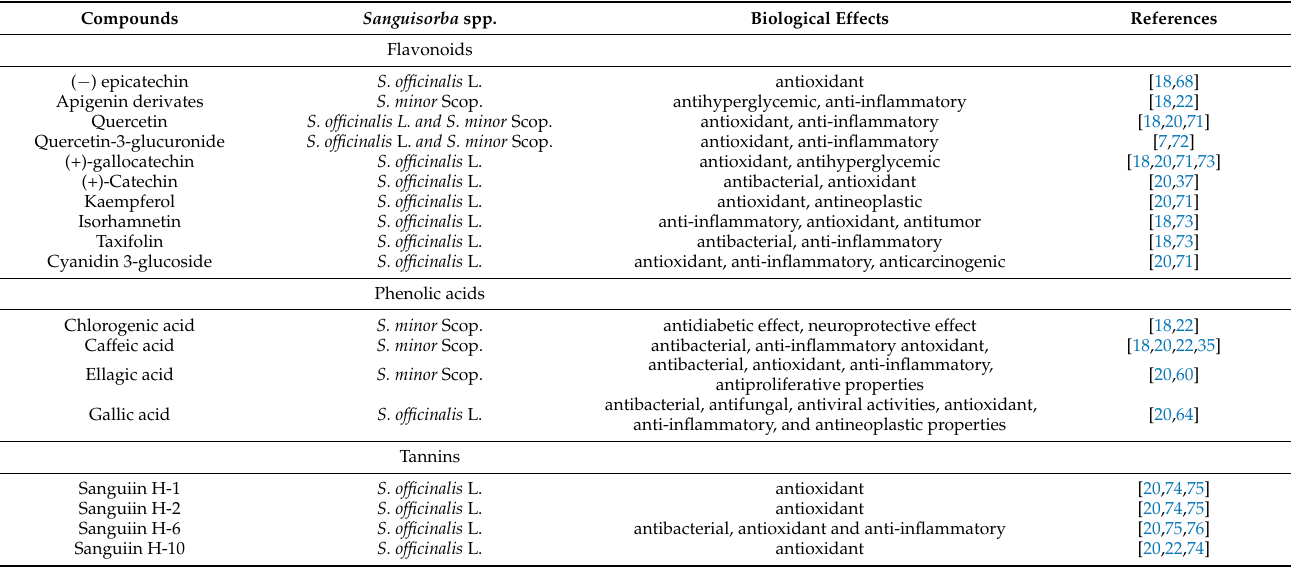
Table 4. Polyphenols and their biological effects from literature identified in Sanguisorba